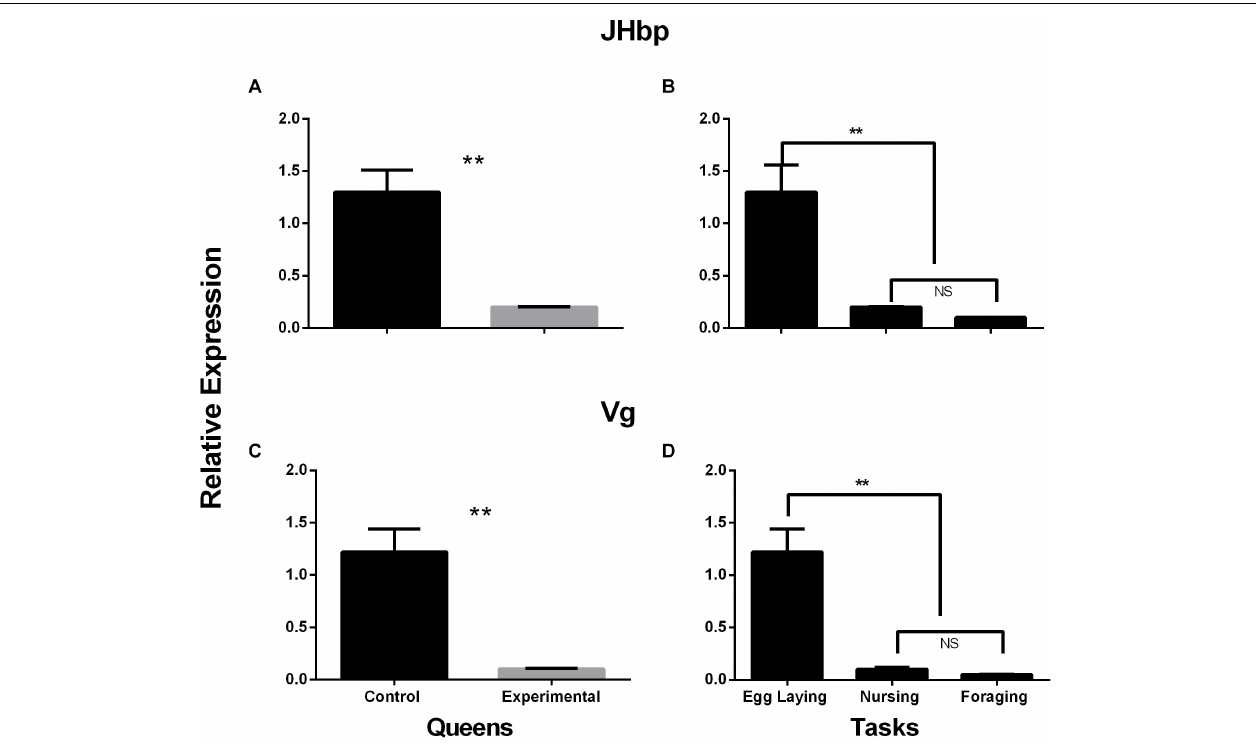
FIGURE 3 | Relative gene expression of JHbp (A,B) and Vg (C,D) in control and experimental nests. Results show differences in gene expression of JHbp and Vg between control or egg laying queens and experimental or nursing and foraging queens. Expression was measured in relative expression to endogenous genes Actin and GAPDH by geometric mean analysis method. n = 33 queens; control queens n = 15, experimental queens n = 18. (A) JHbp expression decreases from control to experimental queens, W = 270, p -value ≤ 0.001, Mean control = 1.30, SE exp = 0.26. (B) Comparing JHbp expression by tasks shows difference between egg laying compared to nursing and foraging, there’s no difference in expression between nursing or foraging queens Kruskal-Wallis chi-squared = 24.21, df = 2, p -value ≤ 0.001, Mean egg laying = 1.30, SE egg laying = 0.26, Mean nursing = 0.20, SE nursing = 0.002, Mean foraging = 0.10, SE egg laying = 0.003. (C,D) . Similar pattern as JHbp is seen with Vg expression, decreases in experimental queens ( W = 270, p -value ≤ 0.001; Kruskal-Wallis chi-squared = 25.19, df = 2, p -value ≤ 0.001, Mean control = 1.22, SE exp = 0.22, Mean egg laying = 1.22, SE egg laying = 0.22, Mean nursing = 0.10, SE nursing = 0.02, Mean foraging = 0.05, SE egg laying = 0.01; (C,D) , respectively. Asterisks (**) = p -value of ≤